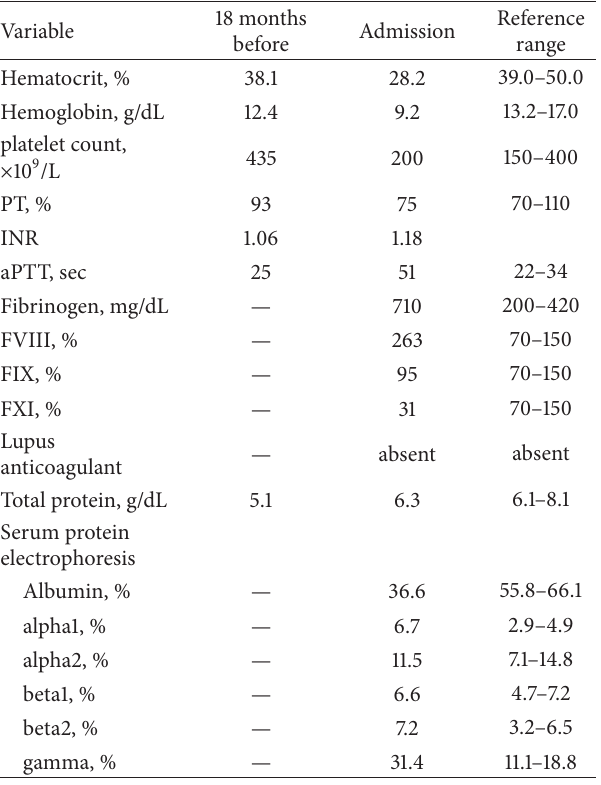
Table 1: Laboratory data.